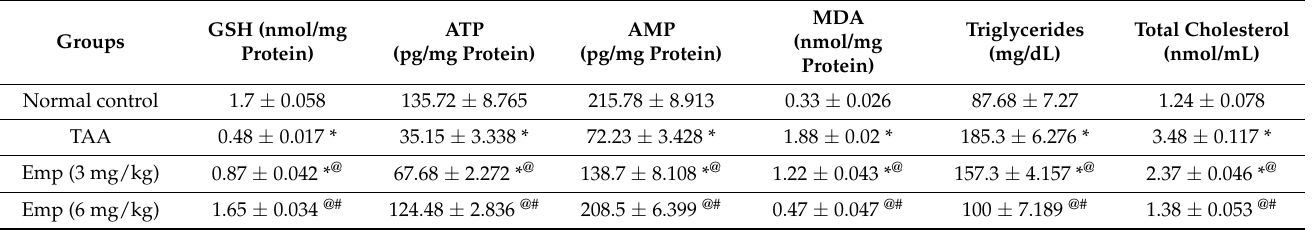
Table 2. Effect of empagliflozin on oxidative stress biomarkers and lipid profile in thioacetamide- intoxicated